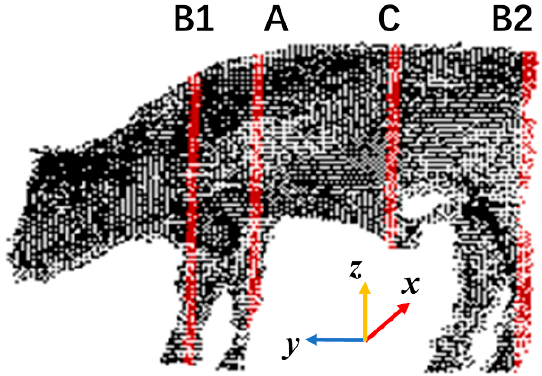
Figure 11. The extracted slices in the key region for body dimension measurement.